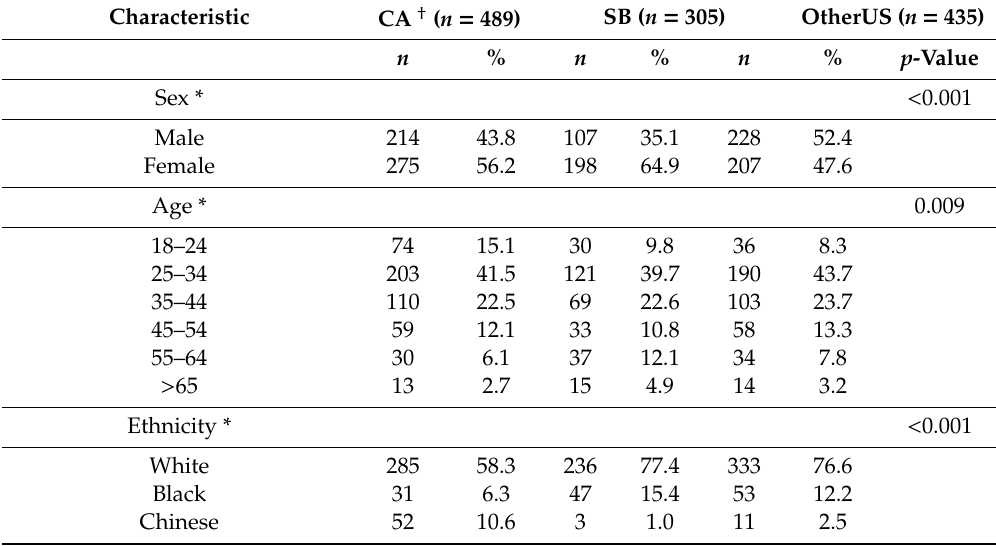
Table 1. Demographics of participants by geographic